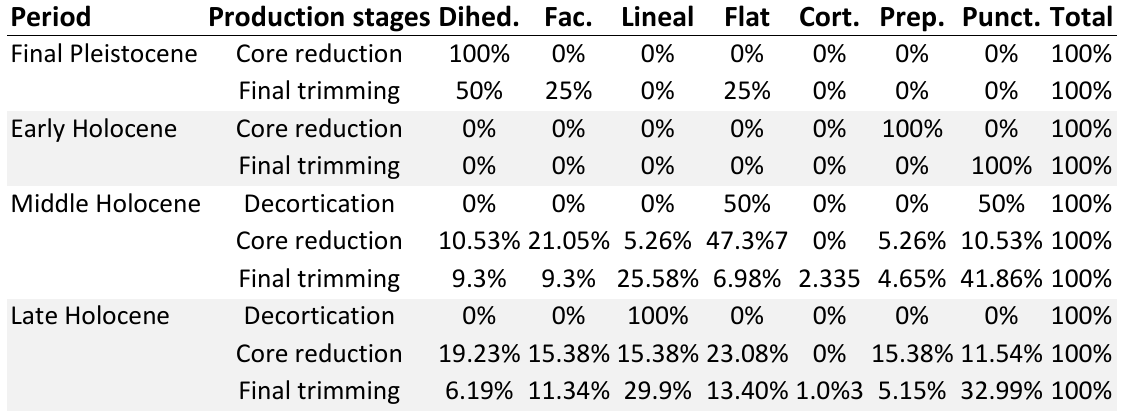
Table 9. Proportion of percussion platforms for each production stage and period of occupation. Abbreviations: Dihed. - Dihedral; Fac. - faceted; Cort. - Cortical; Prep. - prepared; Punct. - punctiform. Period Production stages Dihed.